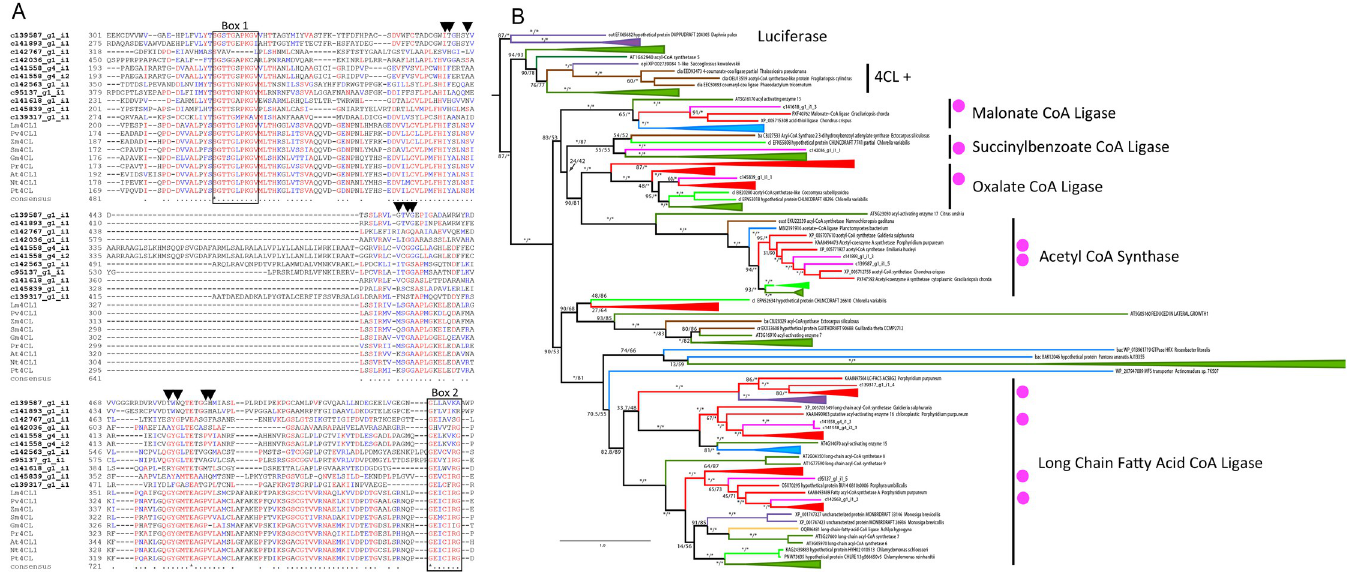
Fig 2. 4CL candidates from C . tuberculosum in relation to plants and other taxa. (A) Partial alignment of C . tuberculosum candidates (bolded) and embryophyte 4CL sequences. Residues involved in hydroxycinnamate binding are indicated with black triangles [47, 48]. Phenylalanine substrate binding pocket [49] is indicated with Box I and Box II. (B) Maximum likelihood acyl-activating enzyme (AAE) gene tree showing relationships between Calliarthron sequences (magenta dots) and other taxa (Embryophyta–dark green, Chlorophyta–light green, Rhodophyta–red, Animalia and Opisthokonta–purple, Bacteria and Cyanobacteria–blue, Oomycota, Mycetozoa and Fungi–yellow, Ochrophyta–brown). Functionally demonstrated plant 4CLs are labelled (+). Additional functional groups are labelled [50, 51]. Ultrafast bootstrap values > 95 are marked by � . Model = WAG+F+G4. Sites with � 80% occupancy were removed. Accession numbers can be found in S1 Appendix.